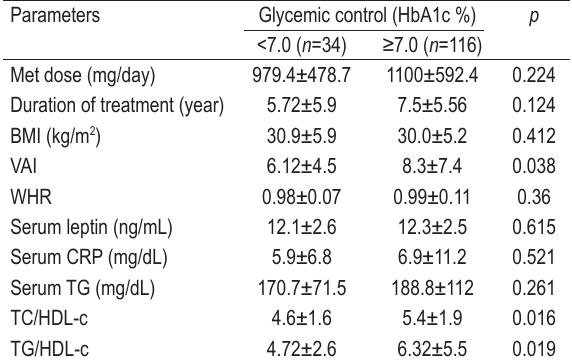
TABLE 2. Variations in the metformin doses and duration of treatment, anthropometric markers, serum levels of leptin and C‑reactive protein, and lipid profile in Iraqi type 2 diabetes mellitus patients according to glycemic control ( n =150)